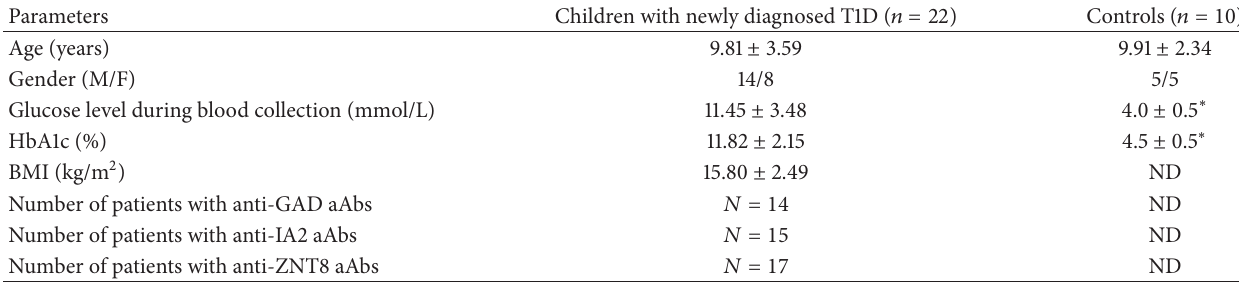
Table 1: Clinical and metabolic characteristics of T1D children and of age-matched